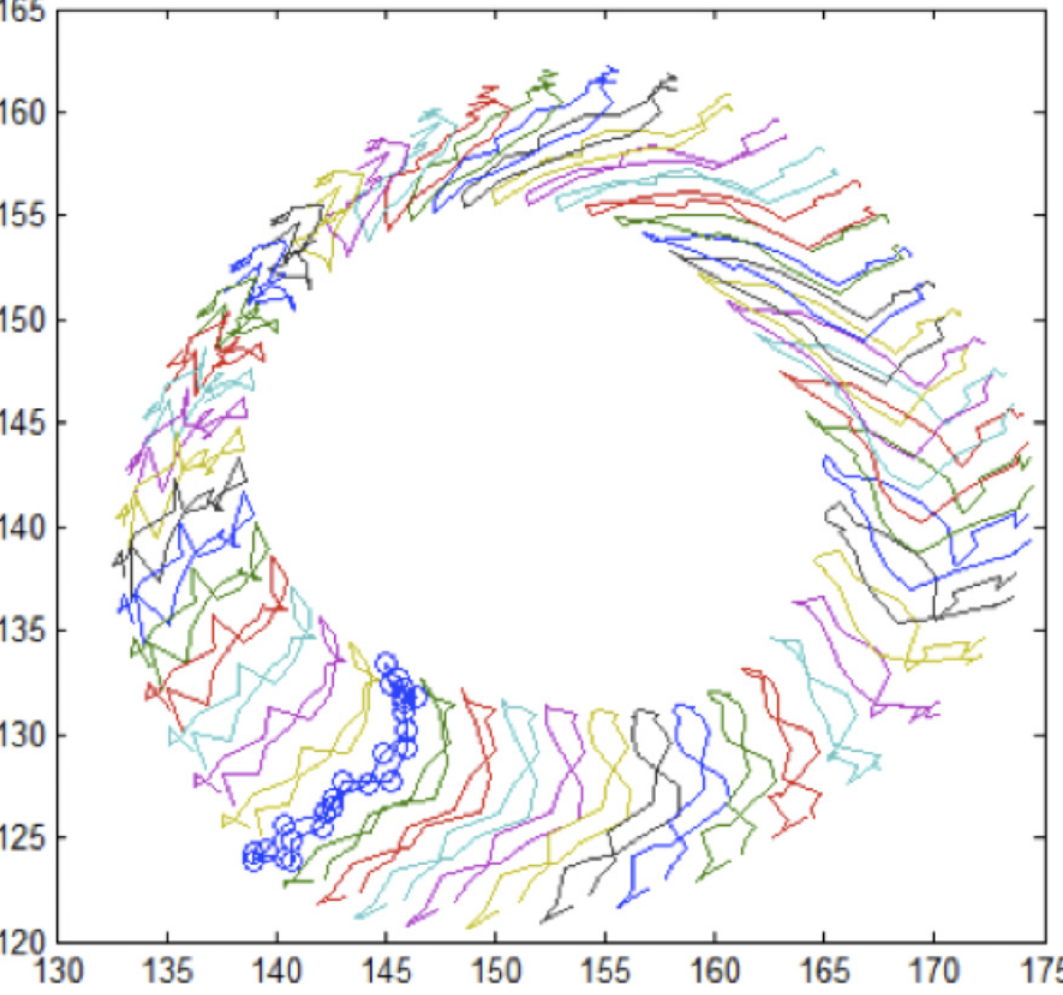
Fig 1. Example of the algorithm based feature tracking of a basal short axis slice. The figure shows the temporal evolution of the relative positions (pixel coordinates) of 48 control points per contour over the cardiac cycle, which in this example consists of 25